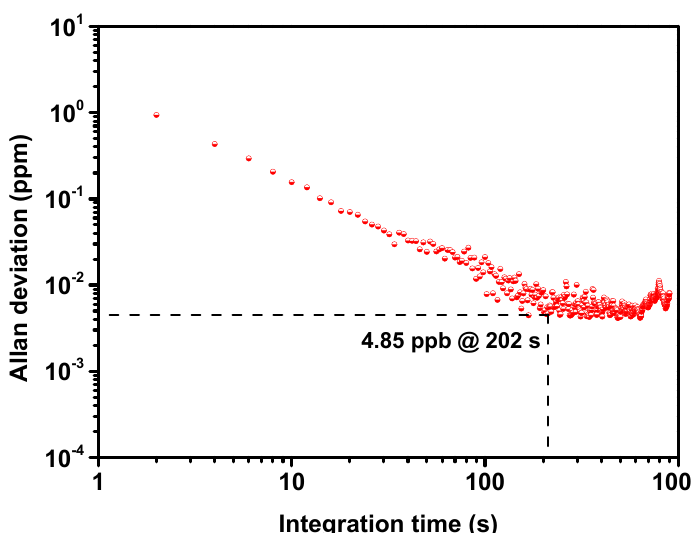
Figure 7. Long-term stability of the compact and low-power-consumption CO sensor ( a ) 10 ppm CO; ( b ) 500 ppm CO.